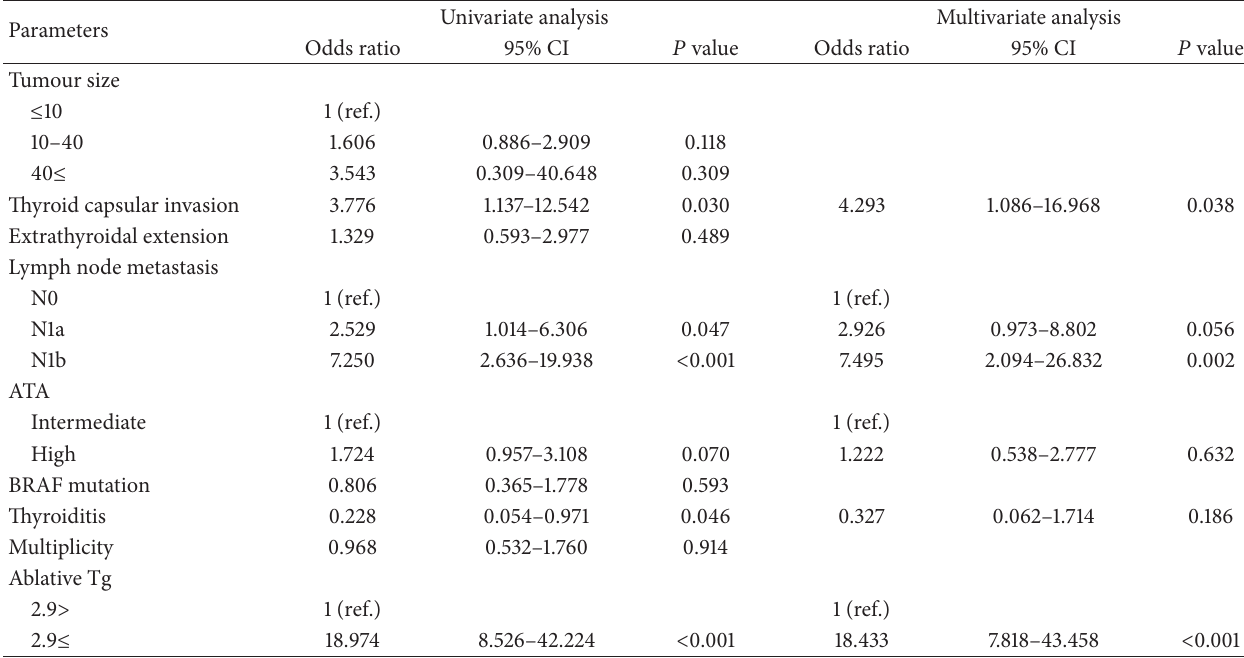
Table 3: Postoperative parameters for predicting detectable